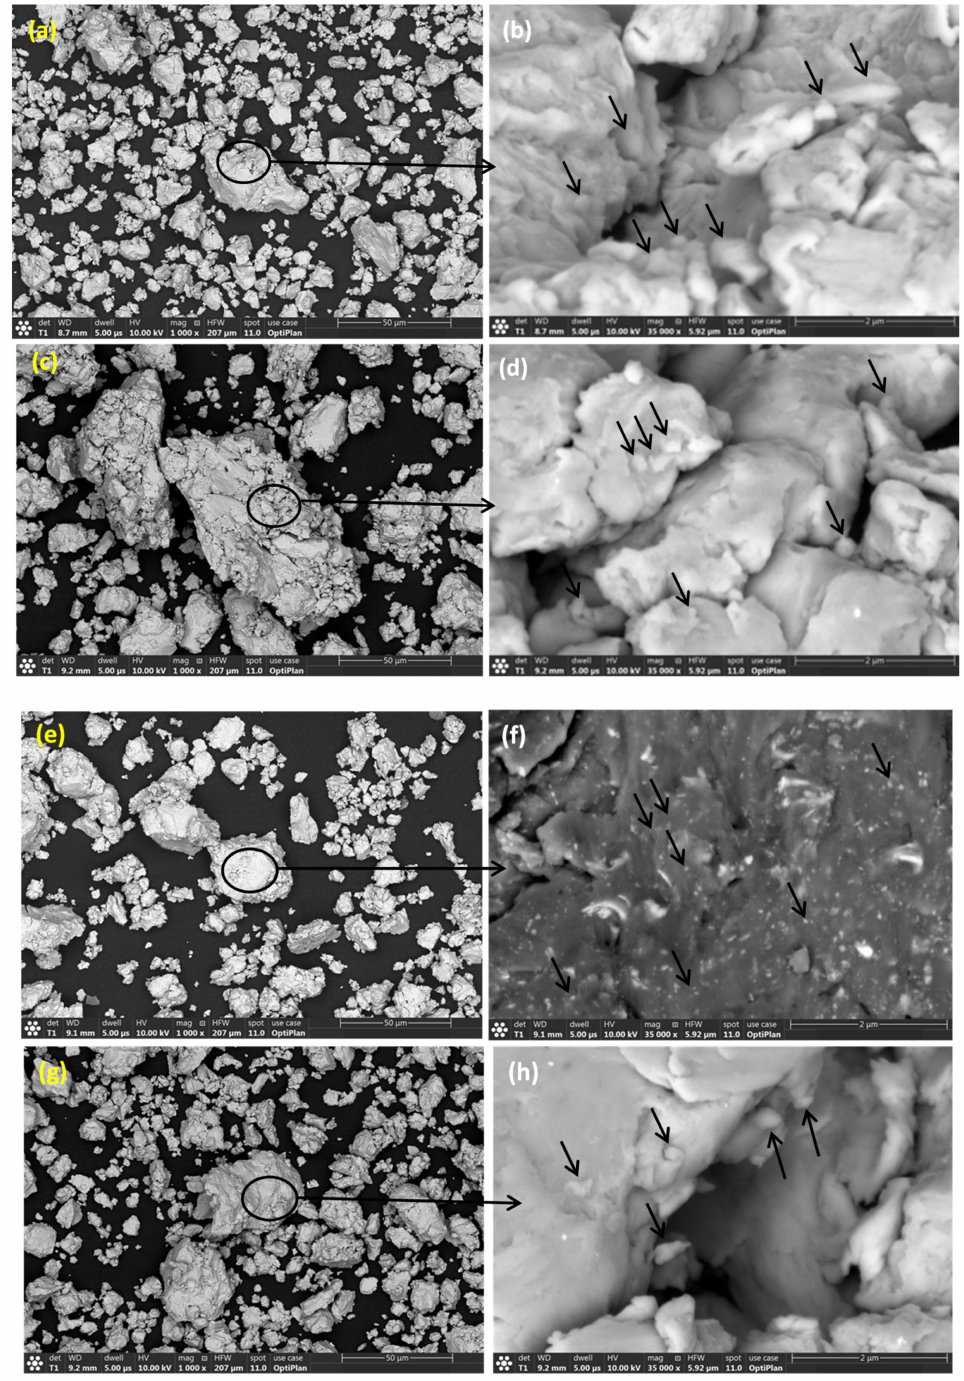
Figure 3. ( a , c , e , g ) BSE images of the morphology of the mAed BM0, BM1, BM2, and BM3 alloys, respectively; ( b , d , f , h ) high magnification BSE images of the circled region in ( a , c , e , g ), respectively. The EDS analysis of the MAed BM0, BM1, BM2, and BM3 alloys are presented in Figure 4. Figure 4a,c,e,g show the SE image of the selected regions for elemental mapping of BM0, BM1, BM2, and BM3 alloys, respectively. Figure 4b,d,f,h display the overlay maps of the MAed BM0, BM1, BM2, and BM3 alloys, respectively. The overlay map in Figure 4b presents the Fe and Mn even dispersion in the MAed BM0 alloy. Figure 4d reveals the uniform dispersion of Fe, Mn and Cu in the MAed BM1 alloy. Figure 4f displays the dispersion of Fe, Mn, and W in the MAed BM2 alloy. Figure 4h shows the